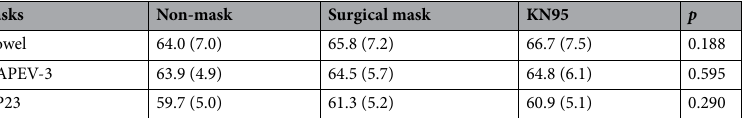
Table 2. Mean (SD) of vocal intensity (dB) in each condition and p values from repeated-measures ANOVA. CAPEV-3, The third CAPEV phrase; RP23, The 2nd and 3rd sentences of the Rainbow